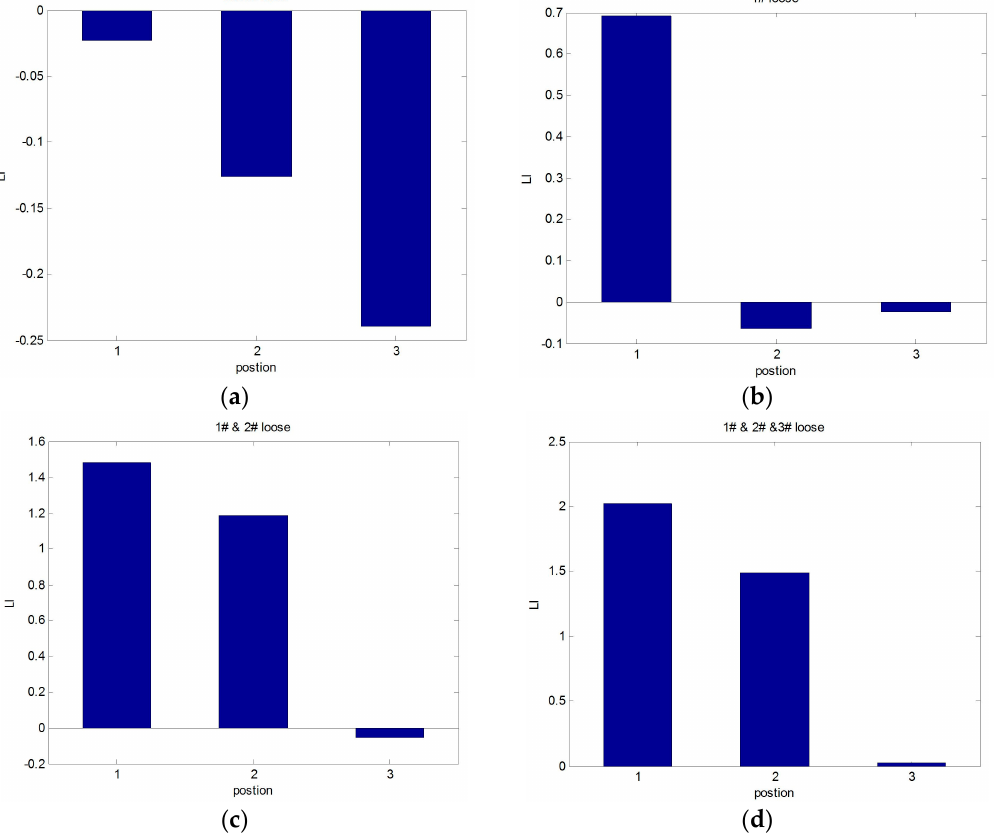
Figure 6. Loose location identification. ( a ) The calculation results of LI in the healthy state; ( b ) the calculation results of LI in the #1 fastener loose condition; ( c ) the calculation results of LI in the #1 and #2 fastener loose condition; and ( d ) the calculation results of LI in the #1 and #2 and #3 fastener loose condition.